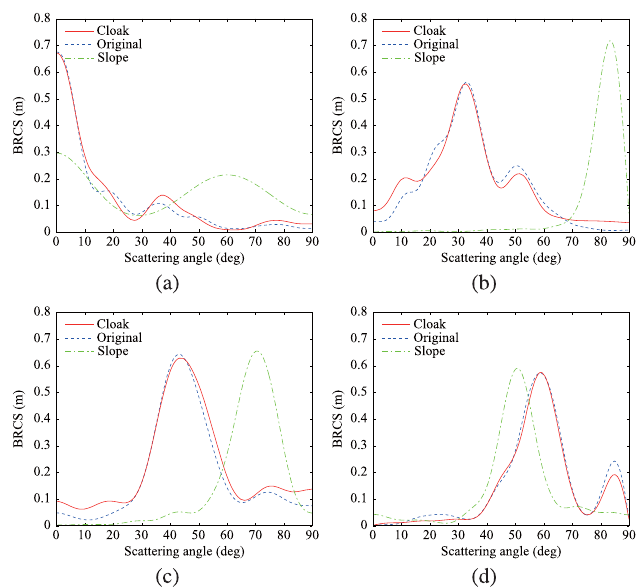
Fig. 6. BRCSs calculated from the measured fi eld distributions for the incident angles of (a) u inc =0 (cid:4) , (b) u inc = 30 (cid:4) , (c) u inc = 45 (cid:4) , and (d) u inc = 60 (cid:4) . In each fi gure, the red solid line is for the cloak, the blue dashed line is for the original area and the green dot- dashed line is for the slope.